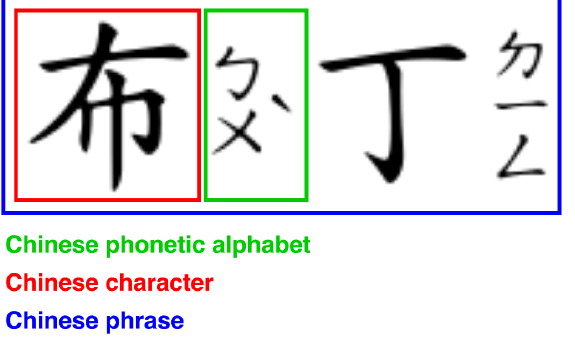
Figure 6. Definition of Chinese